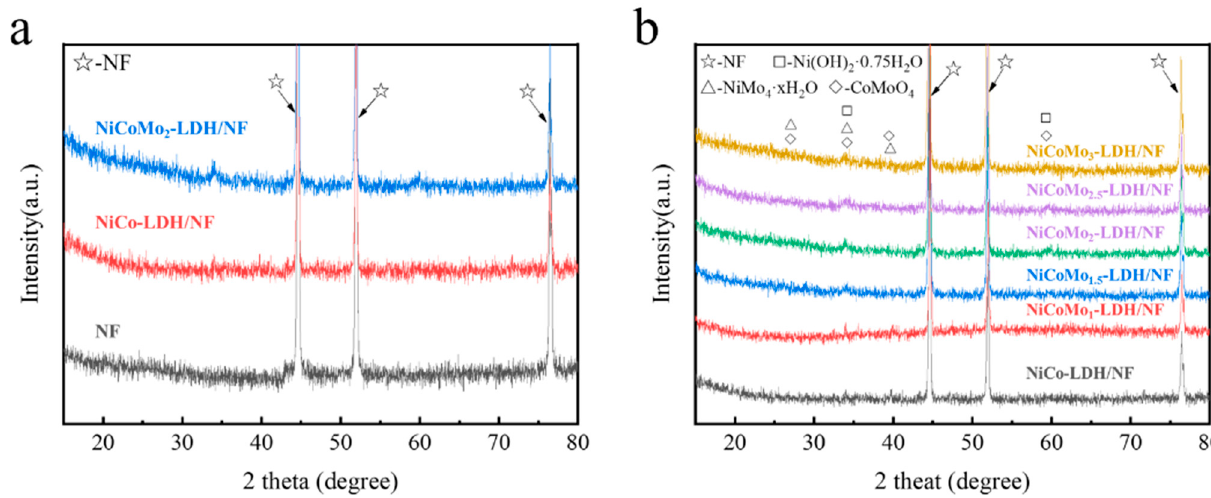
Figure 2. ( a , b ) XRD patterns of the as-prepared samples.